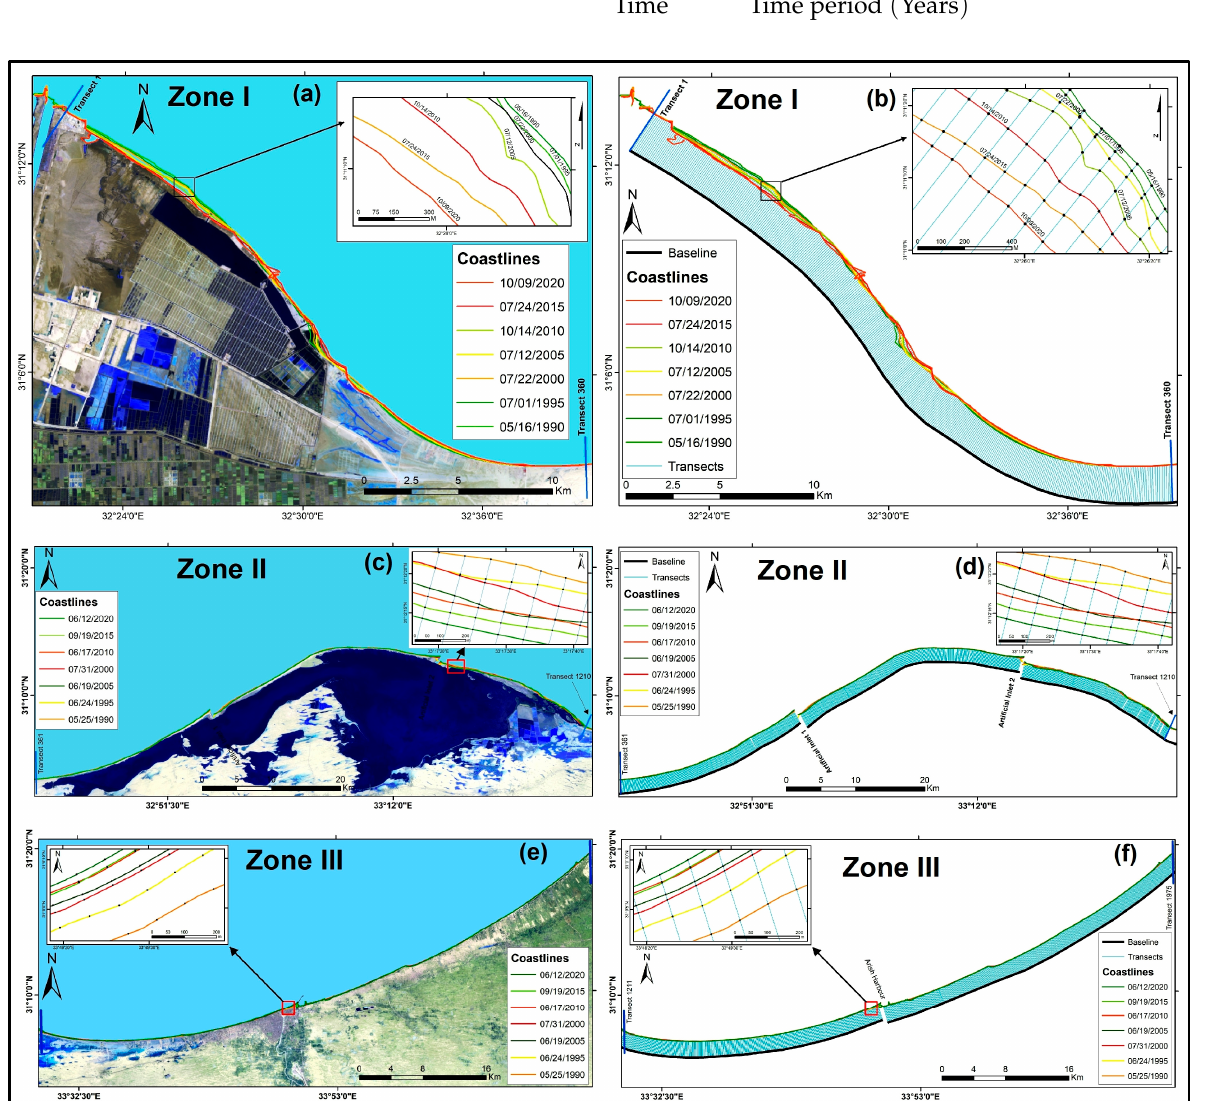
Figure 6. The SMC between 1990 and 2020. ( a ) Tienah Plain Bay in 2020; ( b ) TPB Coastline and Transects at 100 m intervals; ( c ) the Bardaweil Coastal Barrier; ( d ) Bardaweil Coastline and Transects at 100 m intervals; ( e ) Arish Valley Coast; and ( f ) Arish Valley Coastline and Transects at 100 m intervals.